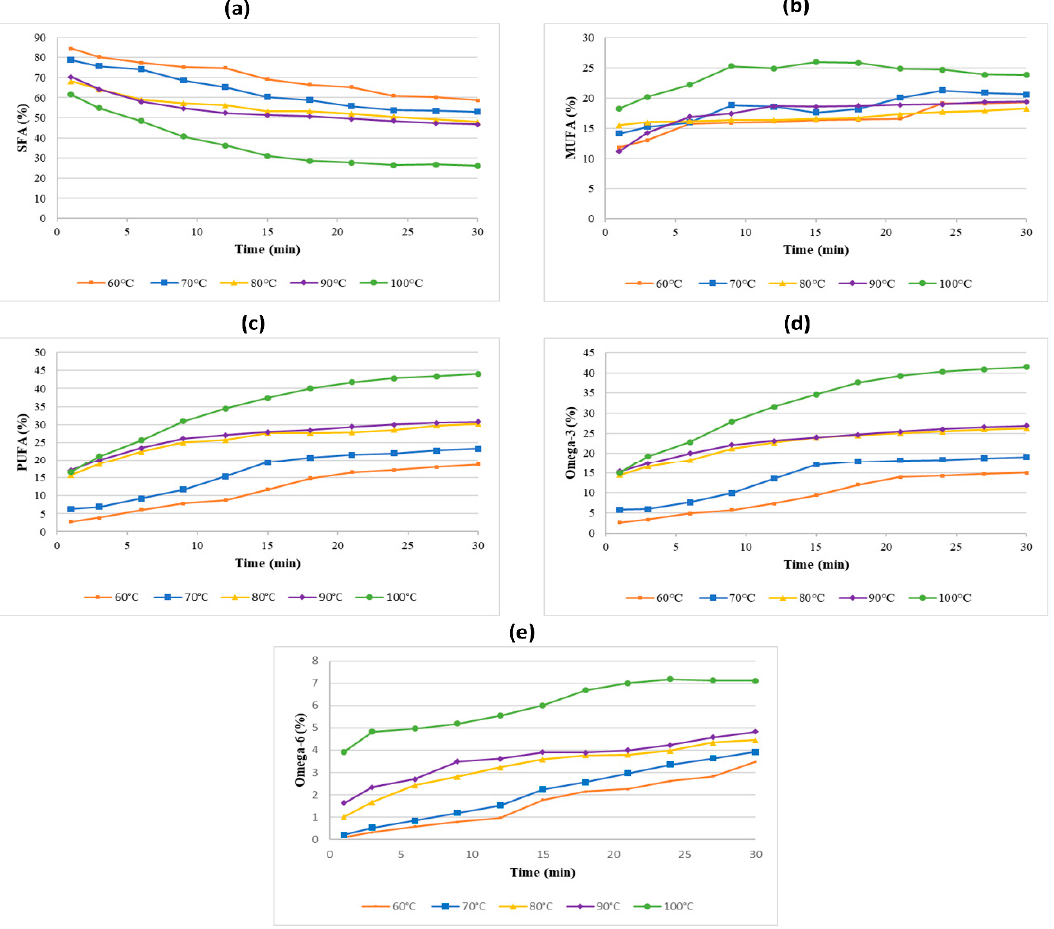
Figure 8. The percentages of ( a ) SFAs, ( b ) MUFAs, ( c ) PUFAs, ( d ) omega-3 fatty acids and ( e ) omega-6 fatty acids obtained from Nannochloropsis sp. microalgae using MAE-brine at different temperatures.